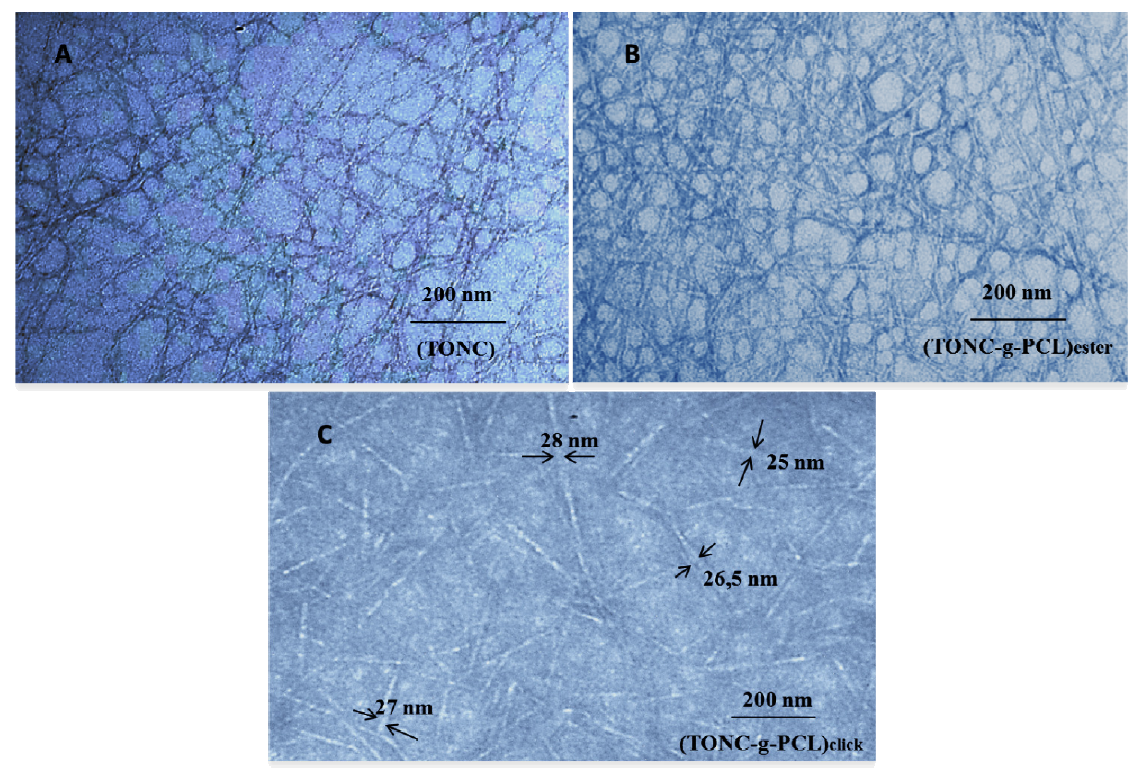
Figure 8. Transmission electron micrographs of: ( A ) TONC; ( B ) (TONC-g-PCL) ( C ) (TONC-g-PCL) click